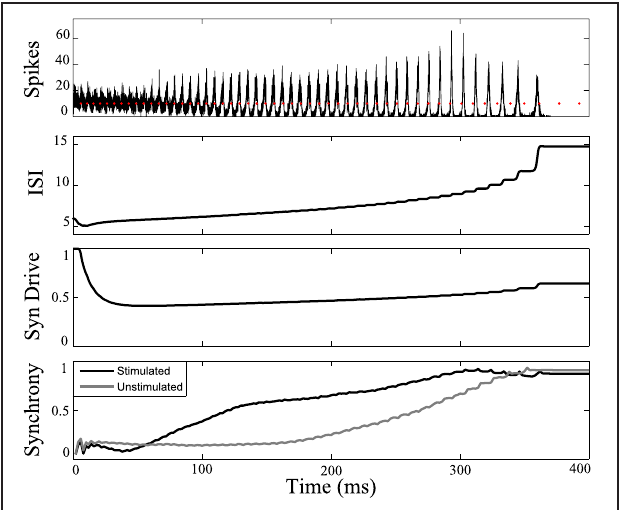
FIGURE 8 | Tonic phase truncation. Network of cells stimulated at 1:1 frequency ratio compared to one measured cell in the network. Bottom: Transition to synchronous clonic phase is earlier (black line) than the unstimulated model (gray line). Here the clonic phase is extended. Graphs labeled the same as Figure 3